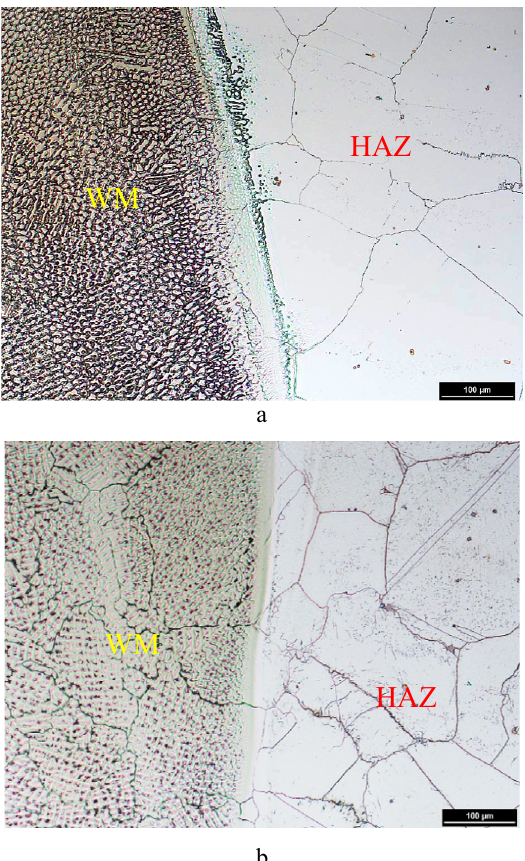
Fig. 9. Microstructure of interface of weld metal and heat affected zone of alloy 800 H: (a) in as-received state, (b) after exposure of 1500 hours in impure helium at 760 °